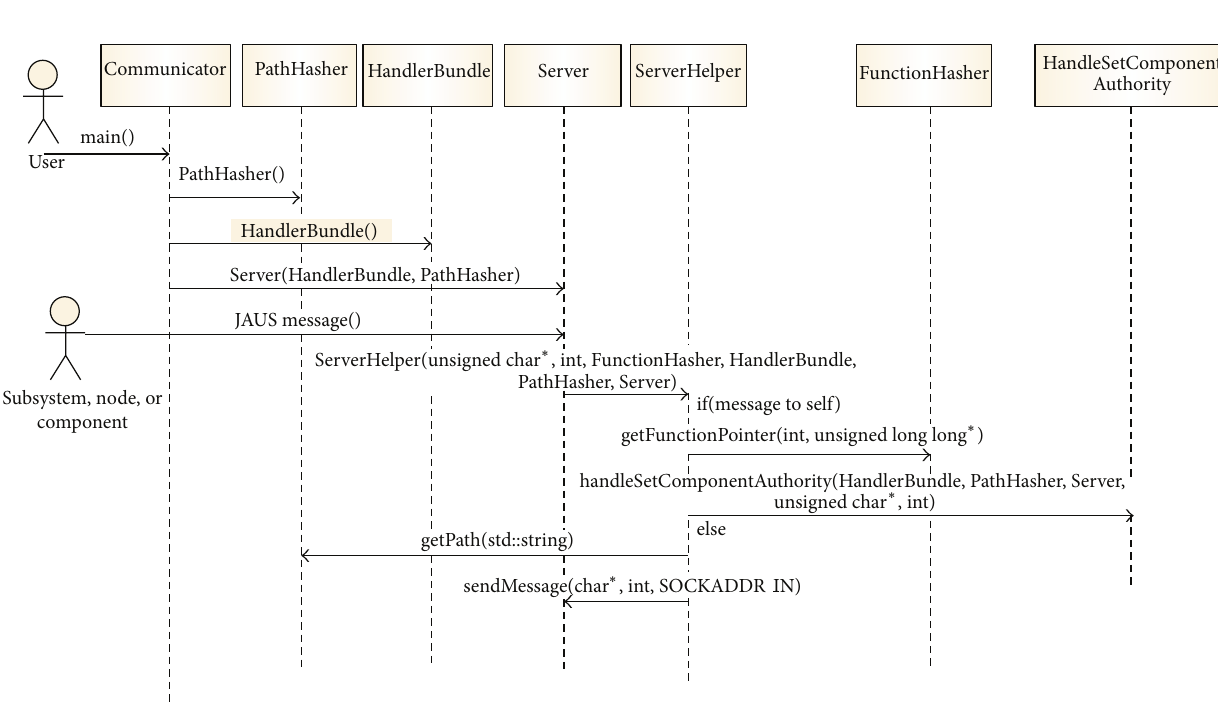
Figure 10: Sequence diagram of Communicator receiving a